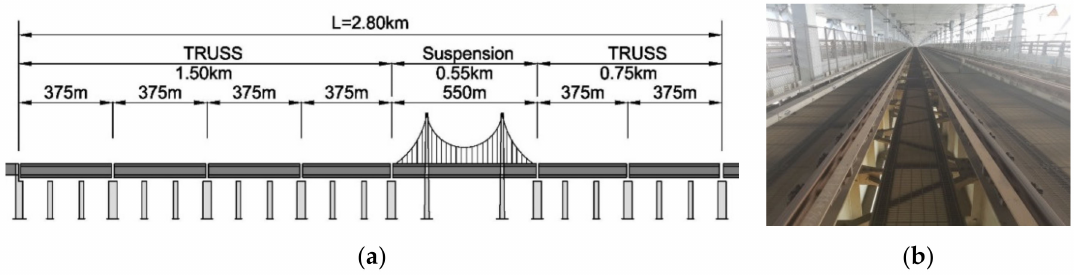
Figure 1. Overview of the Yeongjong Bridge. ( a ) Suspension bridge; ( b ) Truss sections.